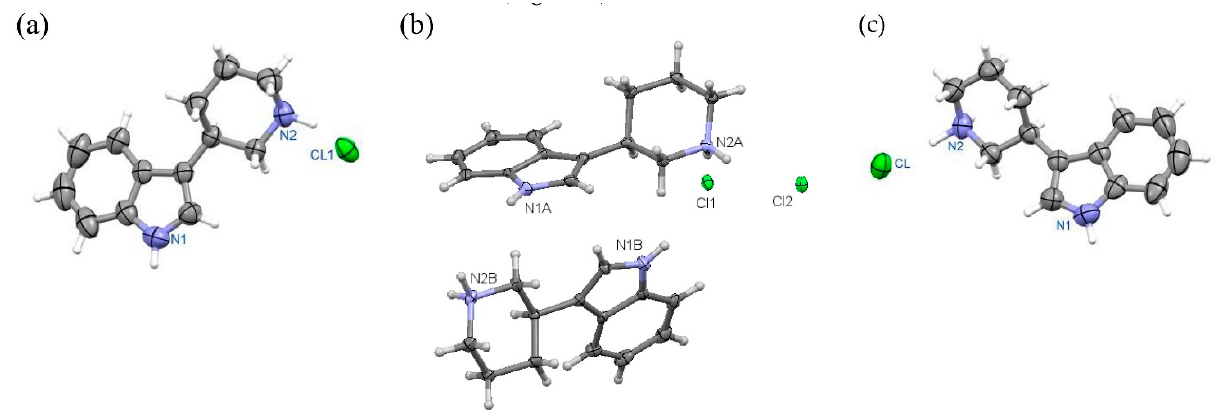
Figure 5. Perspective view of molecules: (R)-10a in orthorhombic ( a ) and monoclinic ( b ) polymorph and ( c ) molecule (S)-11a .